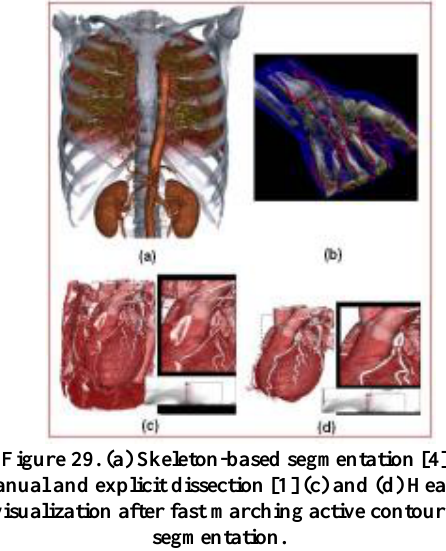
Figure 29. (a) Skeleton-based segmentation [4] (b) Manual and explicit dissection [1] (c) and (d) Heart visualization after fast marching active contour segmentation.